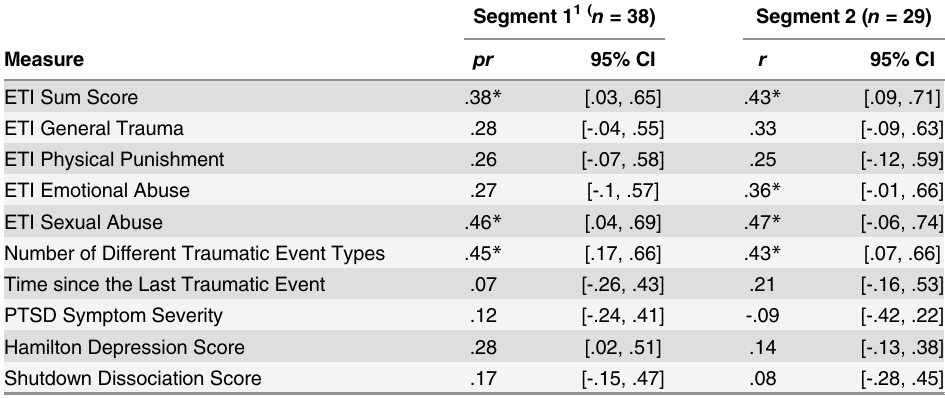
Stress Disorder. 1 partial correlation were calculated for the Segment 1, controlling for the variable African- textured